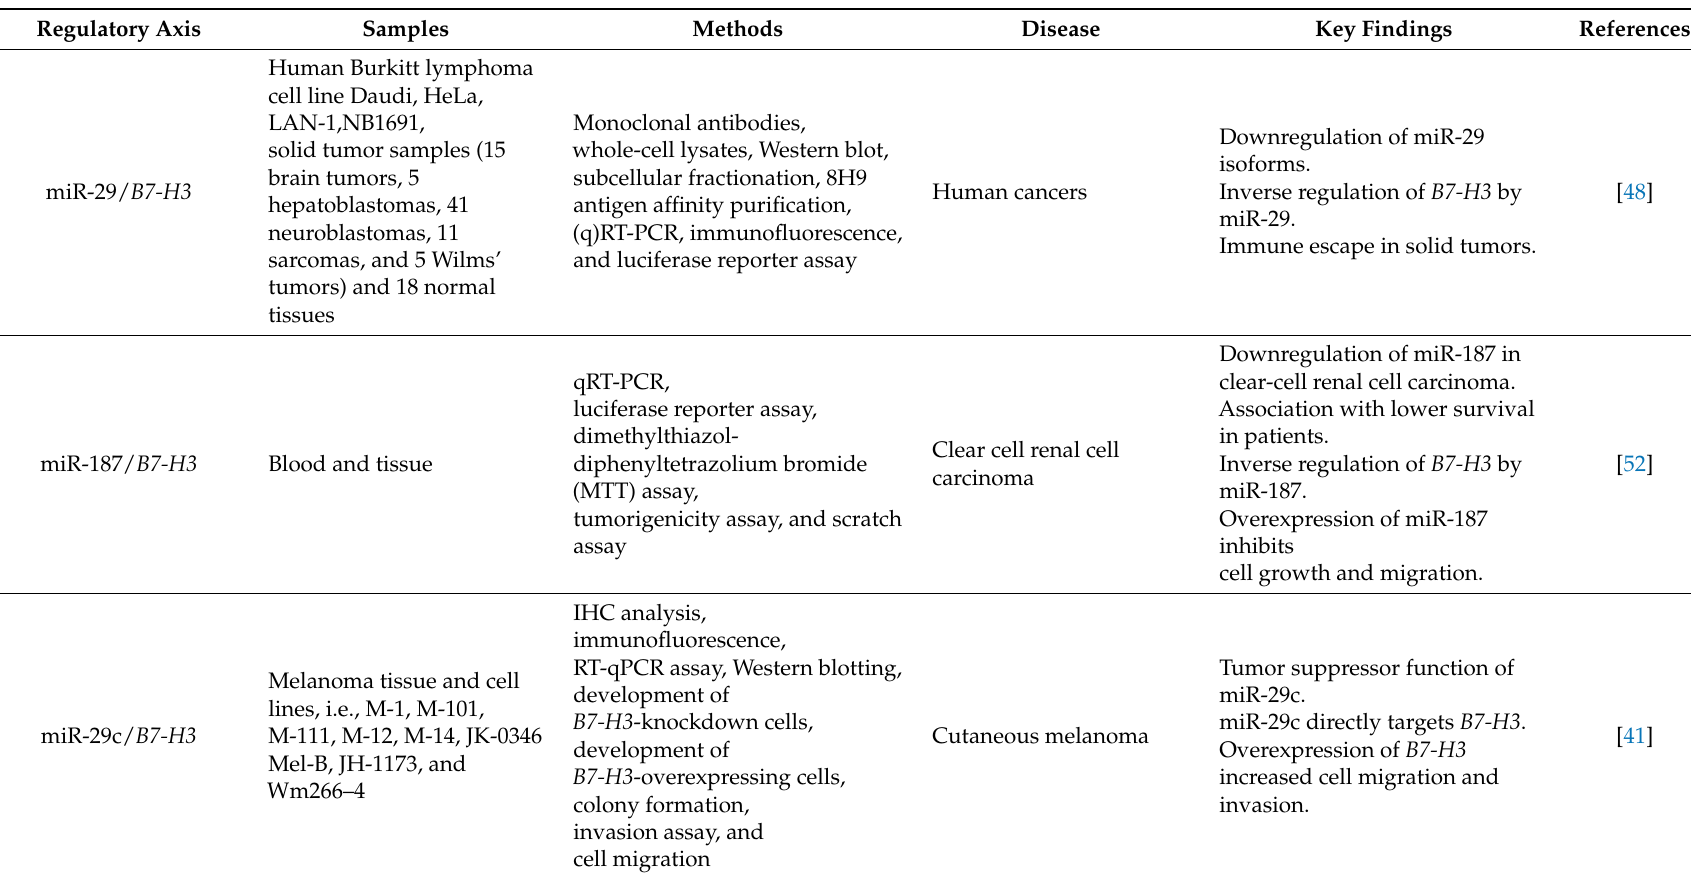
Table 1. The characteristics of the included